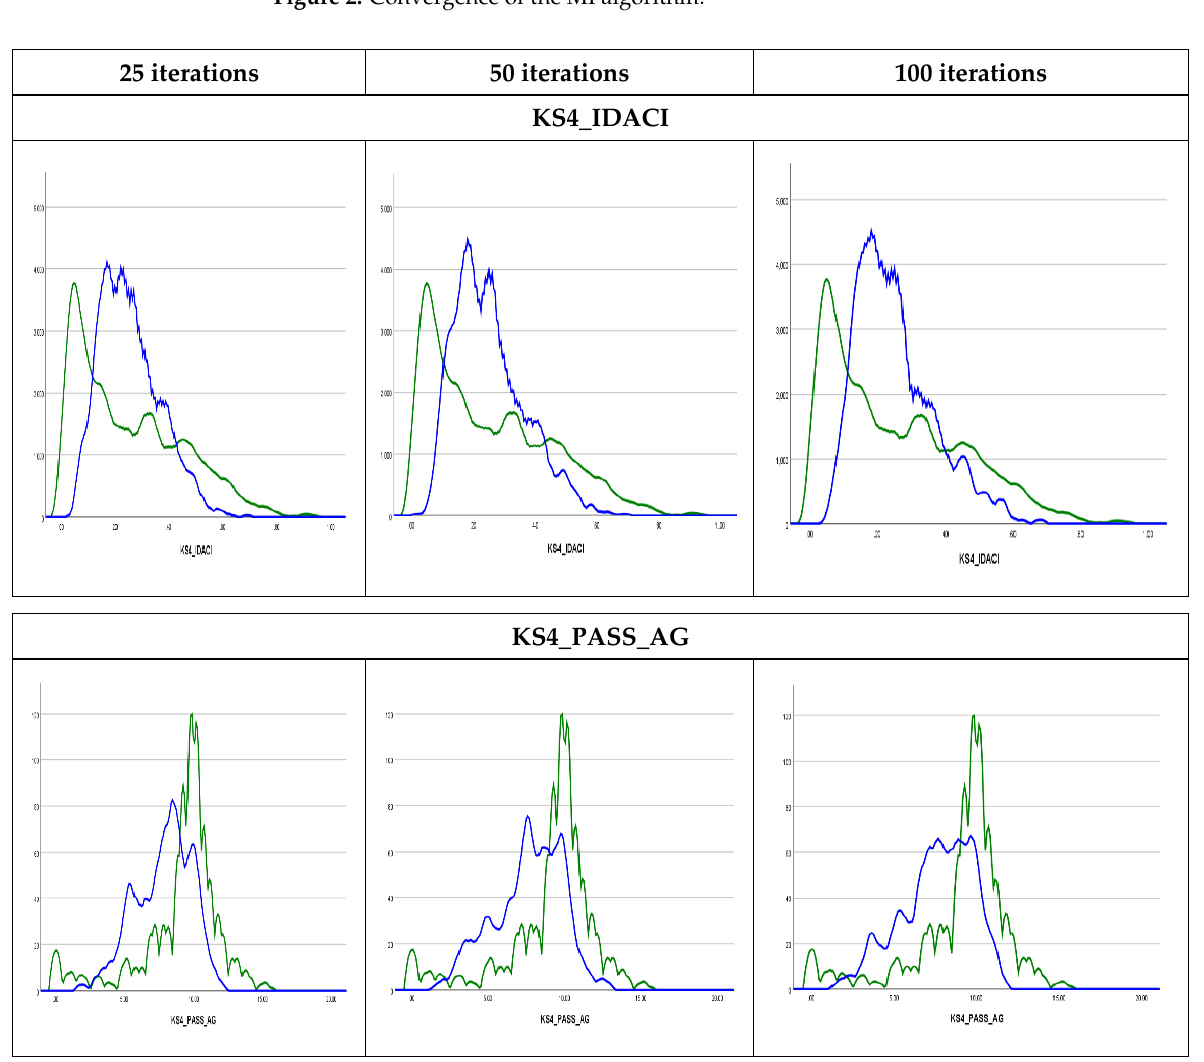
Figure 2. Convergence of the MI algorithm.